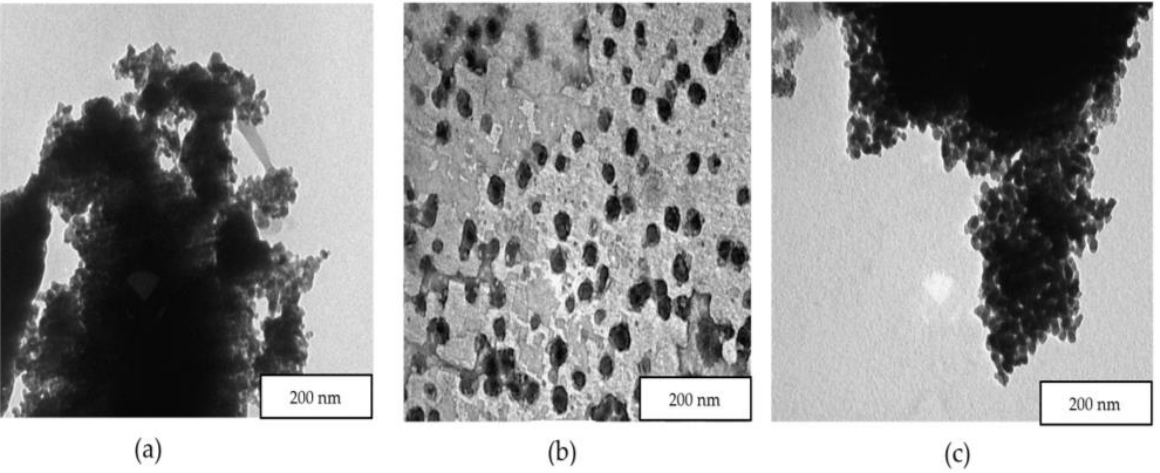
Figure 3. TEM images of ( a ) FeZr, ( b ) MnZr, and ( c ) CuZr.